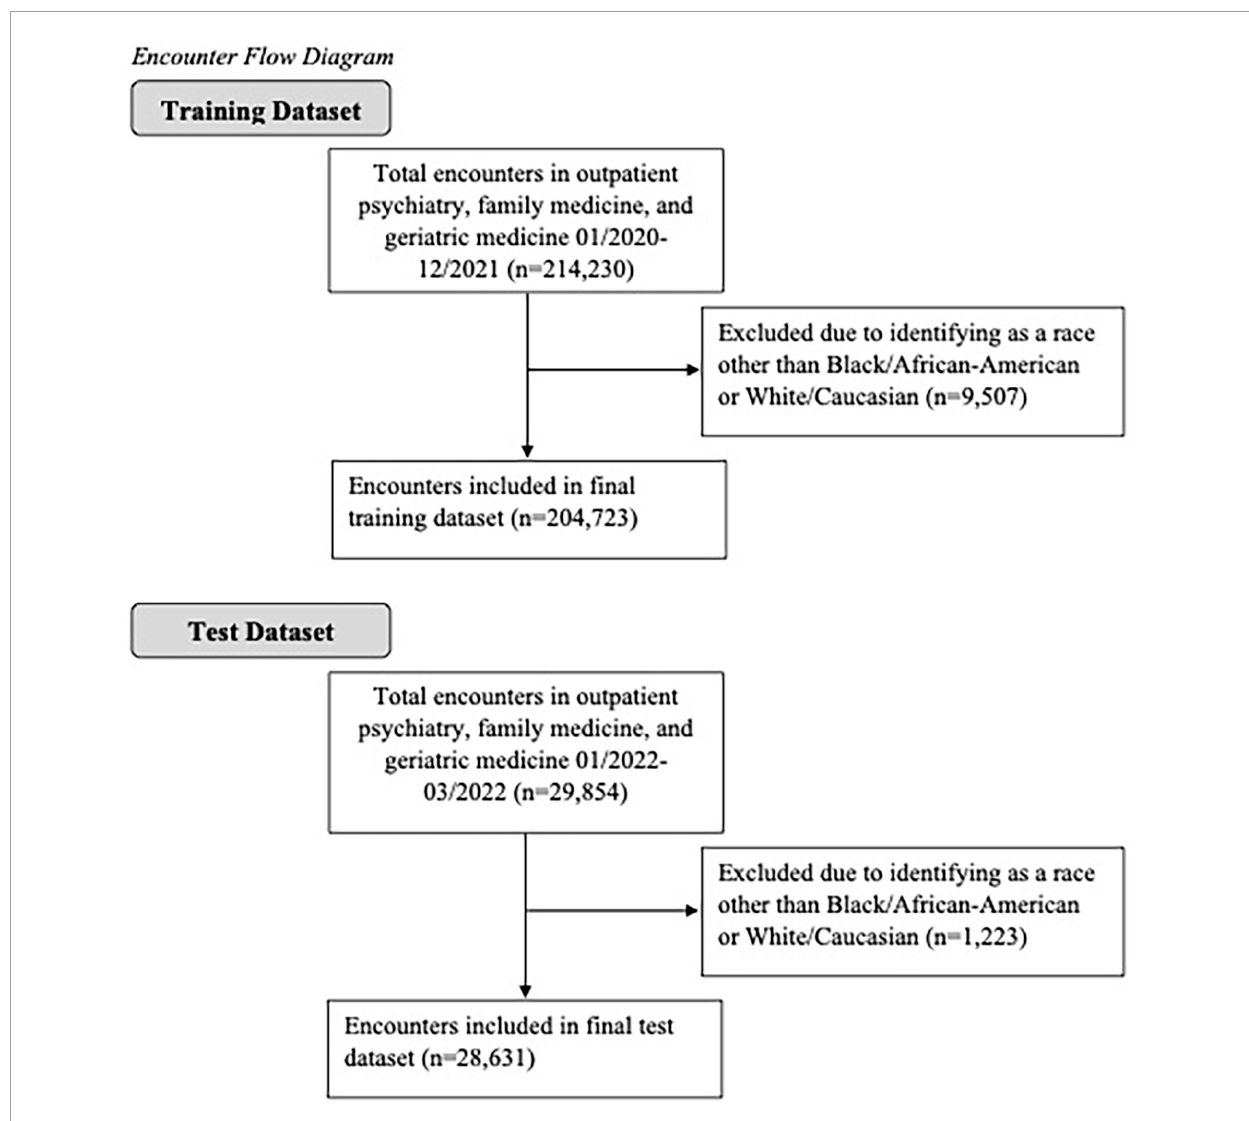
FIGURE1 Encounter flow diagram.